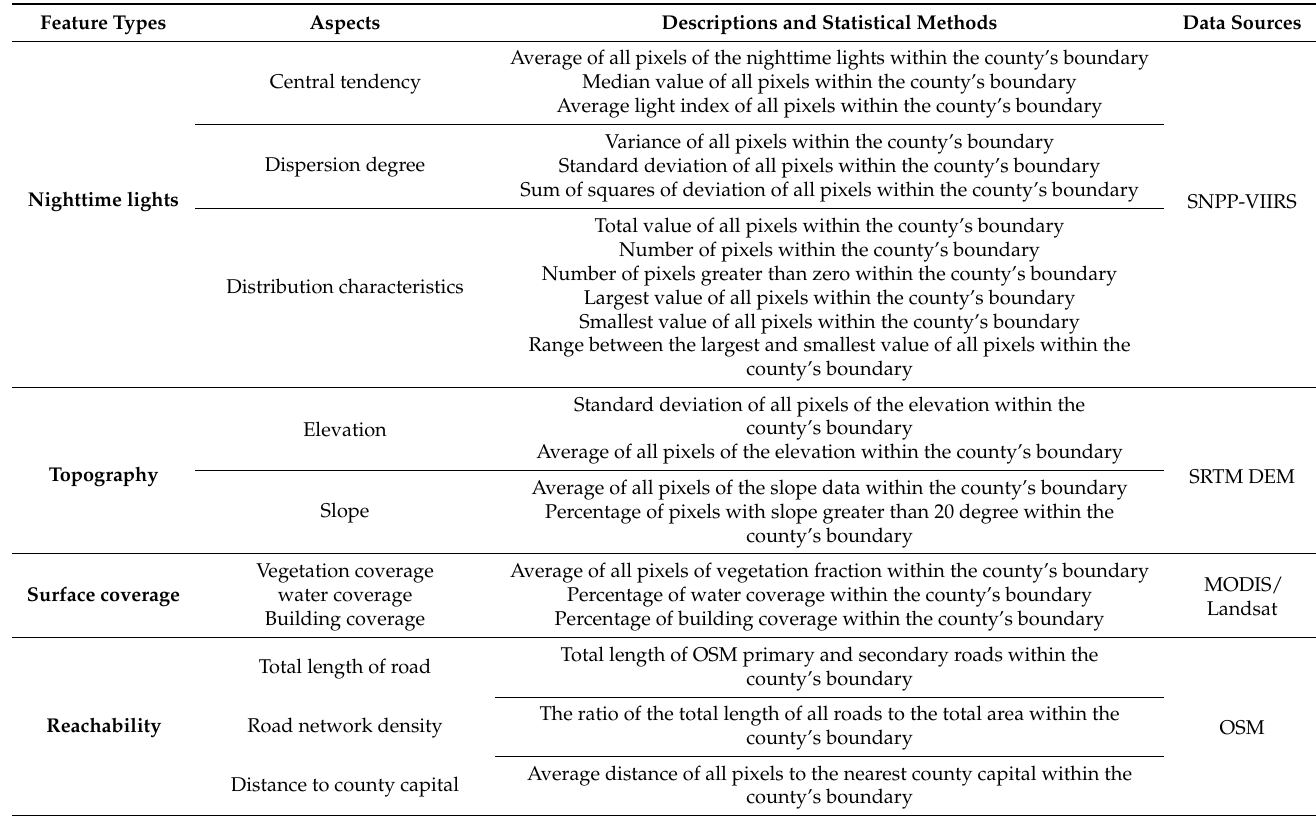
Table 1. Description of feature